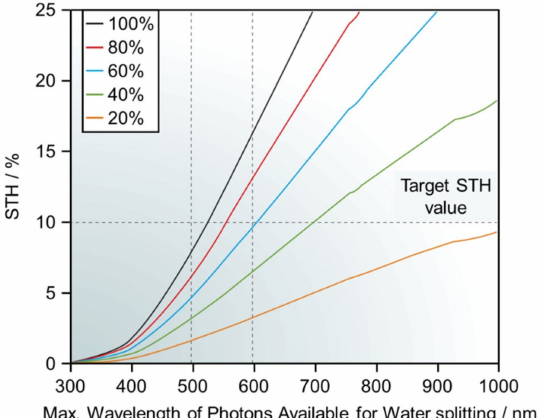
Figure 1. ( A ) Schematic of the expected use of H 2 in a “H 2 -energy society”. ( B ) Coloration of H 2 production methods: ( a ) gray H 2 , ( b ) blue H 2 , and ( c ) green H 2 produced by renewable energy, and ( d ) green H 2 produced by water-splitting photocatalyst. LPG represents liquefied petroleum gas.